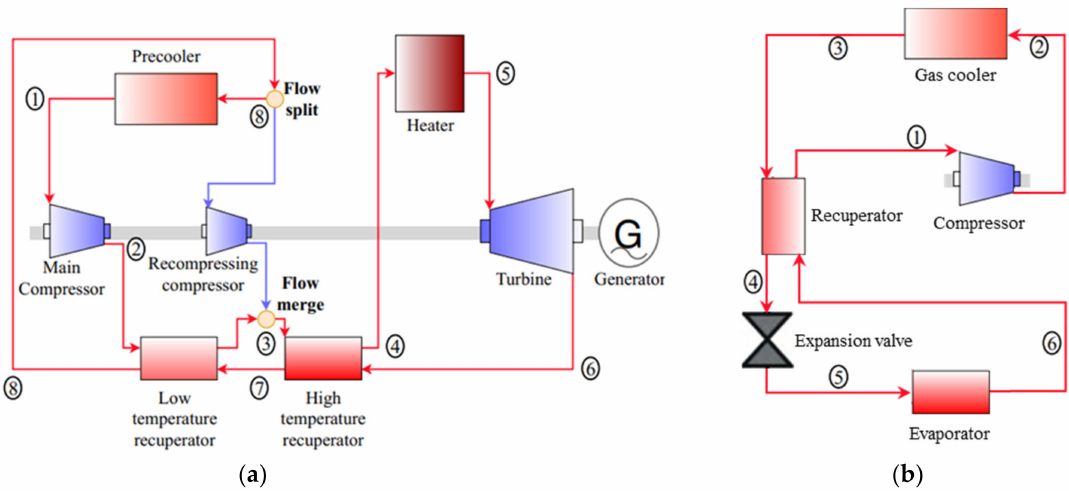
Figure 3. Schematic diagram of a typical SCO 2 recompression Brayton cycle ( a ) and a trans–critical CO 2 cycle ( b